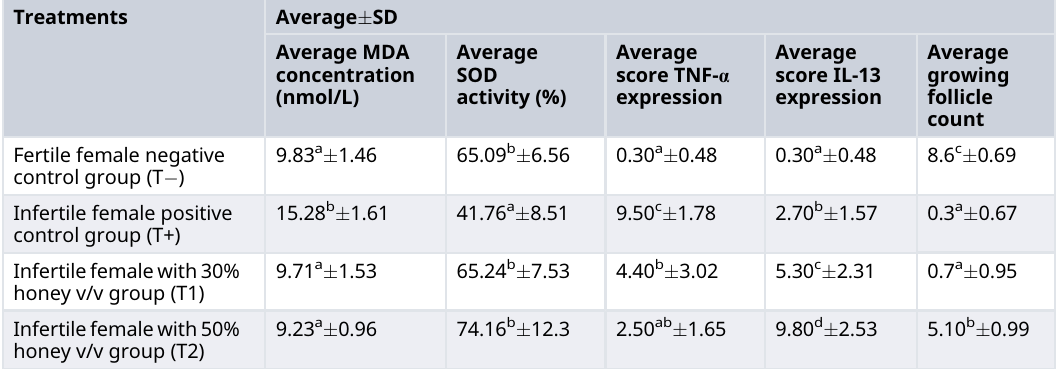
Fertile female negative control group (T (cid:1)